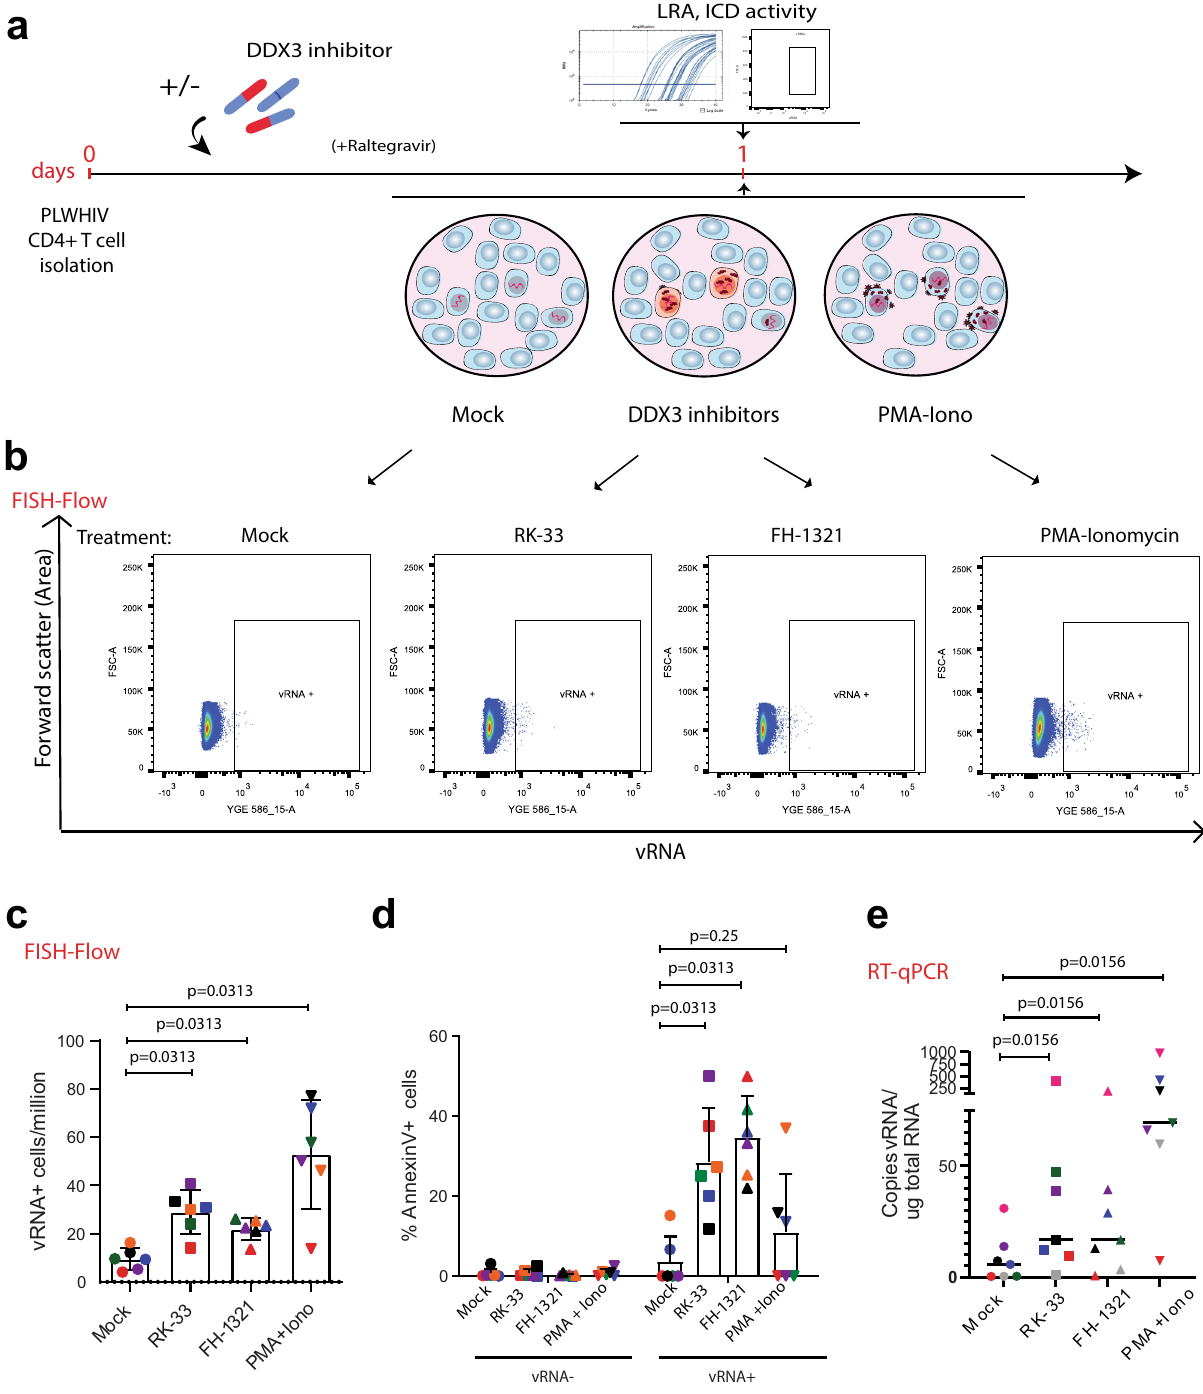
Fig. 5 DDX3 inhibition reverses latency in CD4 + T cells from HIV-1-infected donors and selectively induces cell death. a Schematic of the experiment to test the LRA and ICD activity of DDX3 inhibitors in samples from PLWHIV. CD4 + T cells isolated from HIV-1-infected donors were treated with DMSO (unstimulated), PMA/Ionomycin, and the DDX3 inhibitors RK-33 and FH-1321. For all graphs, different donors are represented by their individual colours consistently as described in Table 3 and symbols represent treatments (Mock = circles, RK-33 = squares, FH-1321 = upward triangles and PMA = downward triangles). b Representative FISH-Flow dot plots from an HIV-1-infected donor as treated in a representing 100,000 cells from each condition. Gating strategy depicted in Supplementary Fig. 5a. c The frequency of vRNA-expressing cells per million as depicted in b were quanti fi ed. Error bars represent the mean ± SD of independent experiments with cells from six different donors, with a minimum of 100,000 events acquired for each condition (Wilcoxon test). d The percentages of AnnexinV positive cells from the vRNA − or the vRNA + cells as quanti fi ed by FISH-Flow. Error bars represent mean ± SD from independent experiments from six different donors, with a minimum of 100,000 events acquired for each condition (Wilcoxon test). e Copies of vRNA/ μ g RNA from cells as treated in a were quanti fi ed by nested RT-qPCR. Error bars represent the mean ± SD of independent experiments with cells from seven different donors (Wilcoxon